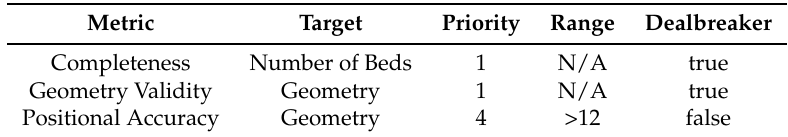
Table 6. Hospital Capacity Requirement Profile: The dealbreaker attribute and geometry validity have been derived with priority 1, Geometry Validity gets priority 1 by definition and Positional Accuracy as a geometry metric receives priority 4.